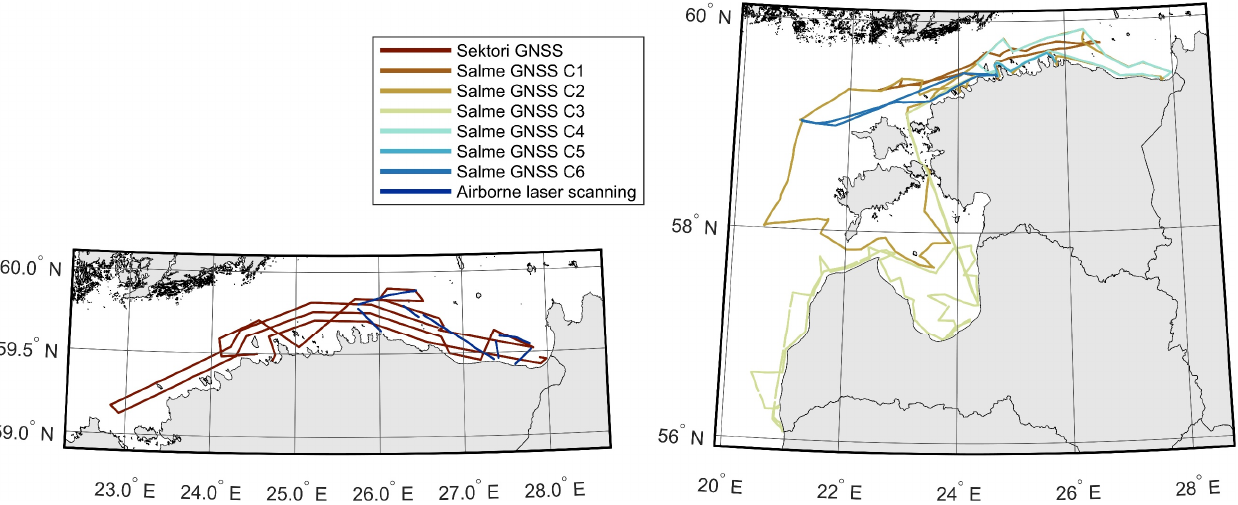
Figure 4. Shipborne GNSS-determined and airborne laser scanning-derived marine profiles of geoidal heights.